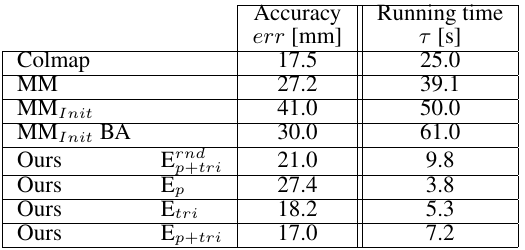
Table 6. UAV dataset. Average position error ( err ) and running times ( τ ). MM Init and MM are the global and sequential SfMs in MicMac. MM Init BA corresponds to the BA refinement on the initial solution. Note that the times for Ours concern only the BA step. In E rnd p + tri a mean value over 1000 repeated calculations is